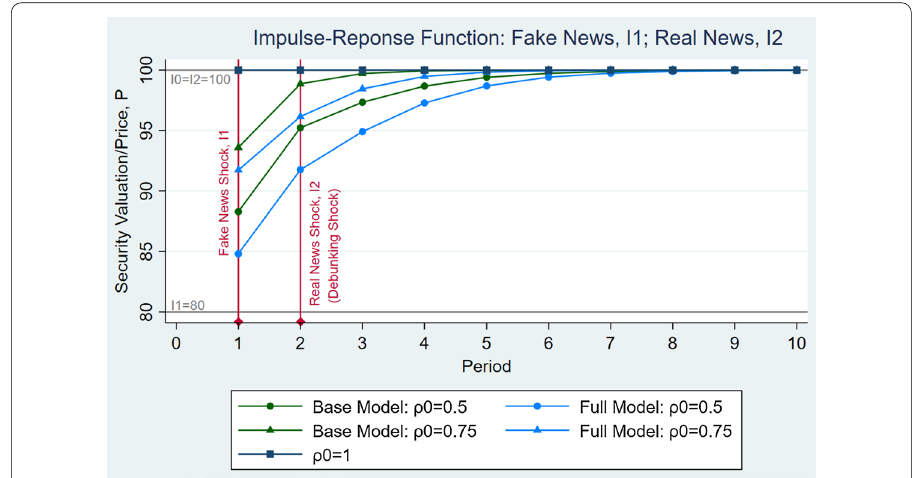
Fig. 3 Impulse-response function: fake news, I1; real news,